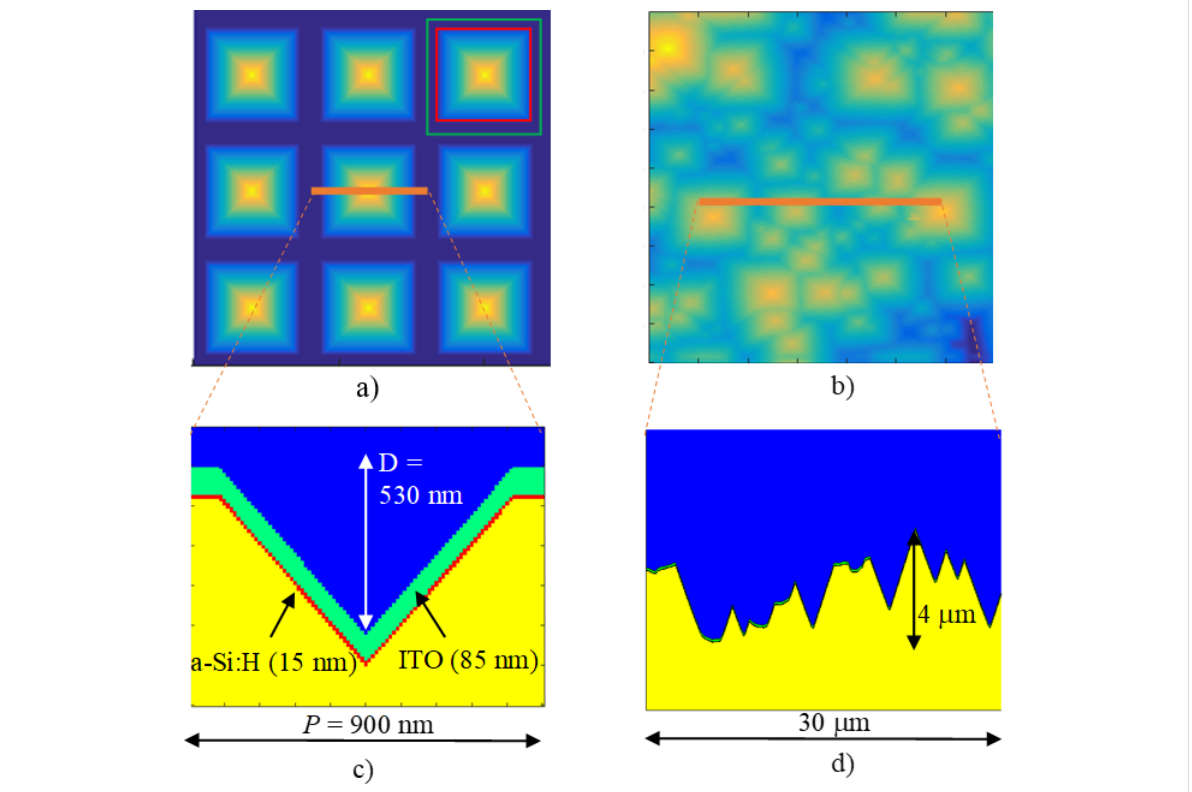
Figure 4: The top and cross-sectional views of the simulated partial structures, applied to the front part of the solar cell. (a, b) simulated top views of inverted pyramid and random pyramid textures. (c, d) Corresponding cross-sectional views, including thin layers as present in the front part of the analyzed solar cell (not seen in (d)). The pixilation observable in the thin layers in c) is a result of sublayer discretization in RCWA (100 equivalently thick sublayers for the texture are shown). In a), the area of the pyramid is marked with red square, while area of the unit cell is marked with a green square. The PF factor, defined by the ratio of these two areas, is